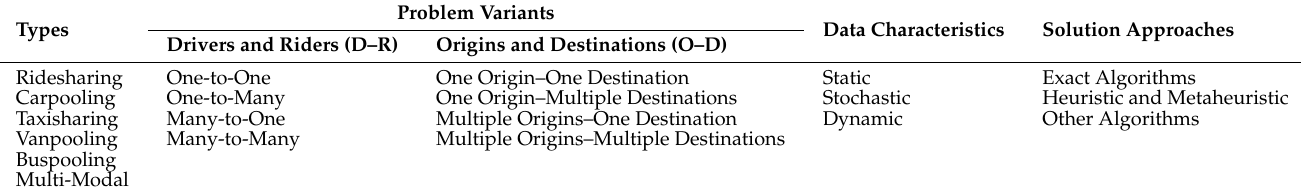
Table 4. Classification of the Shared Mobility